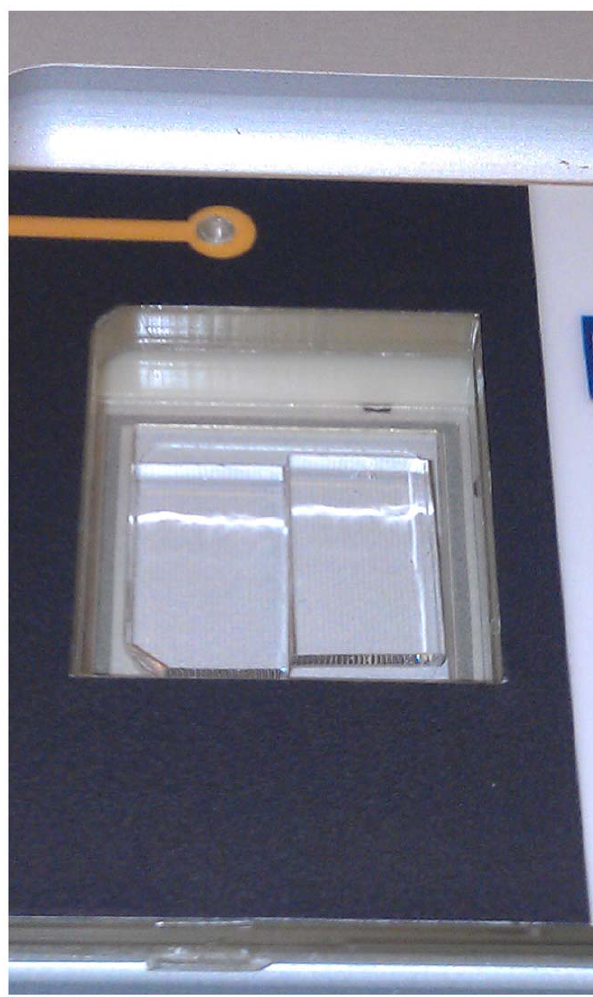
Figure 1. Multiple Surfaces. A surface subdivided in two permits parallel mapping efforts during a single run with a single set of consumables. doi:10.1371/journal.pone.0027085.g001 genome within the limits of certainty for the detection of cut sites over the span of the longest molecules included in the assembly.